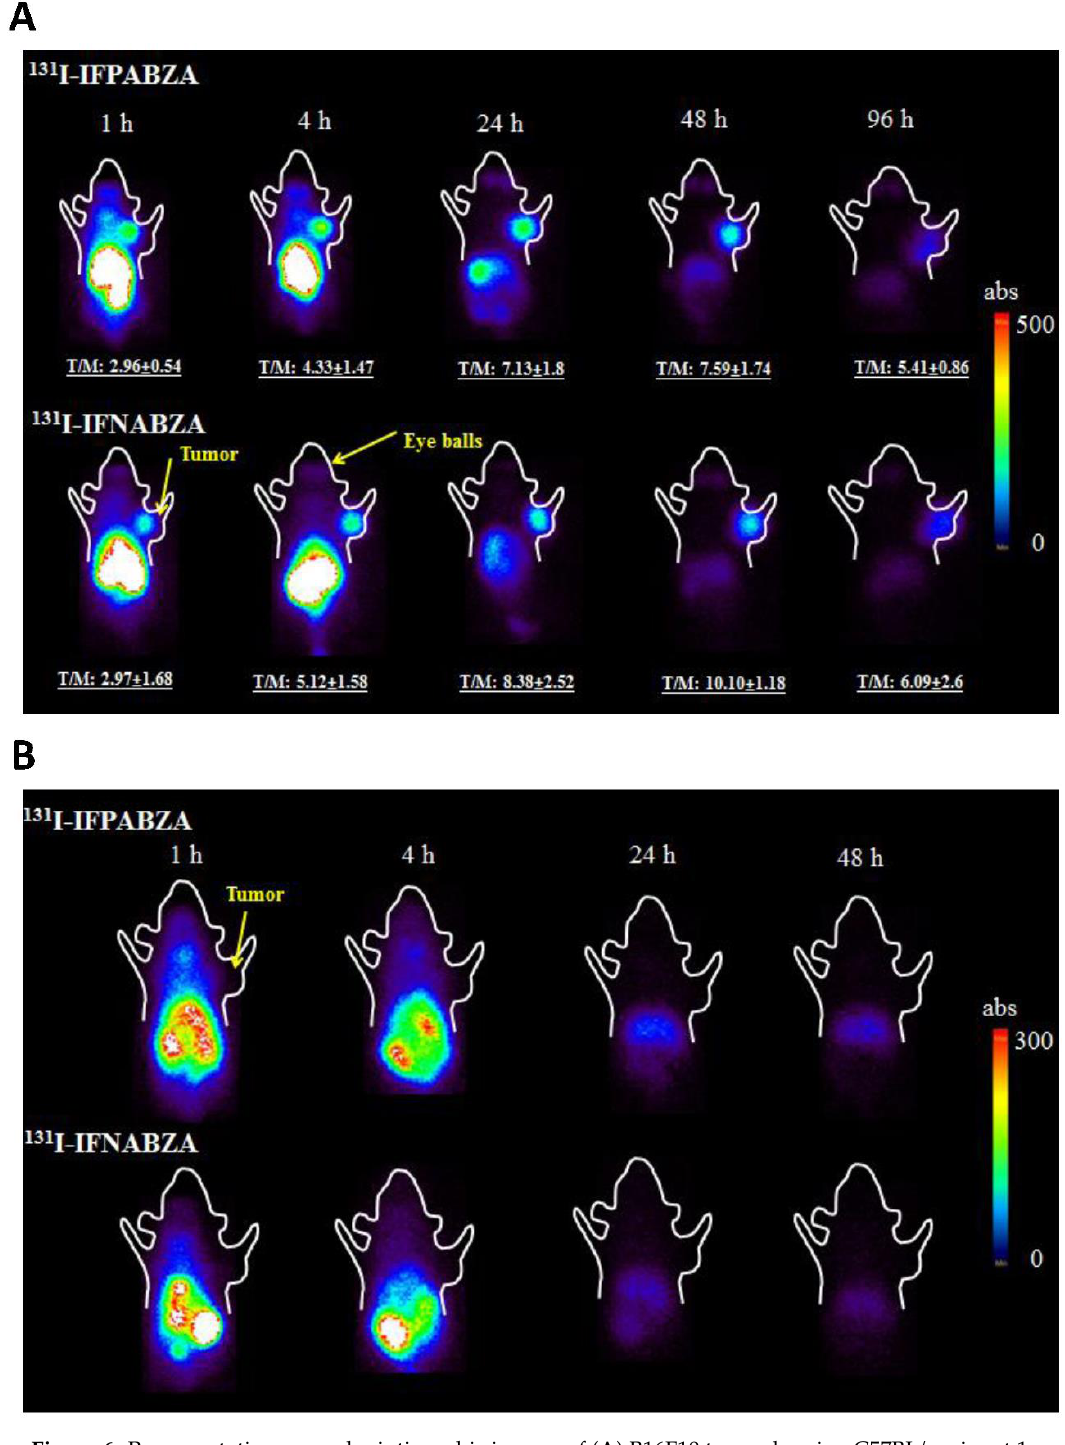
Figure 6. Representative coronal scintigraphic images of ( A ) B16F10 tumor-bearing C57BL / c mice at 1, 4, 24, 48, and 96 h p.i. ( B ) A375 amelanotic xenograft-bearing BALB / c nude mice at 1, 4, 24, and 48 h administered with 131 I-IFPABZA (top) and 131 I-IFNABZA (bottom).